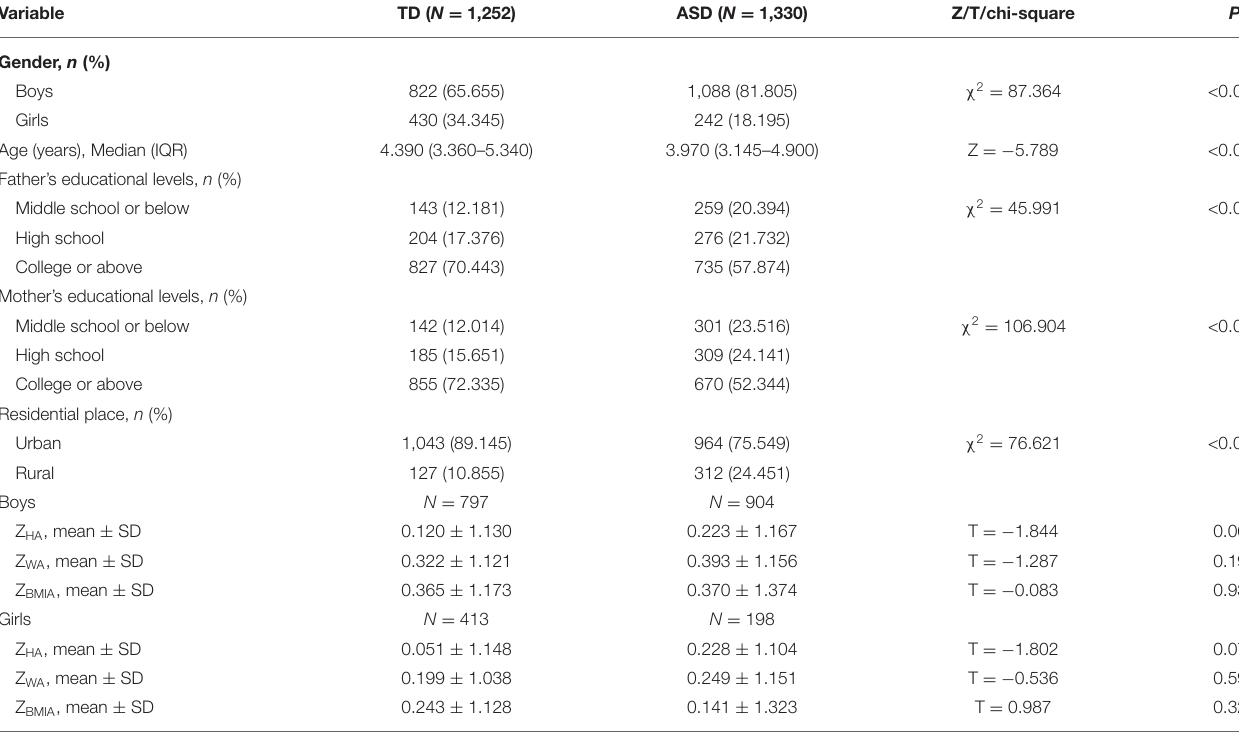
TABLE 1 | Demographic characteristics of the participants in TD and ASD groups. Variable TD ( N = 1,252) ASD ( N = 1,330)